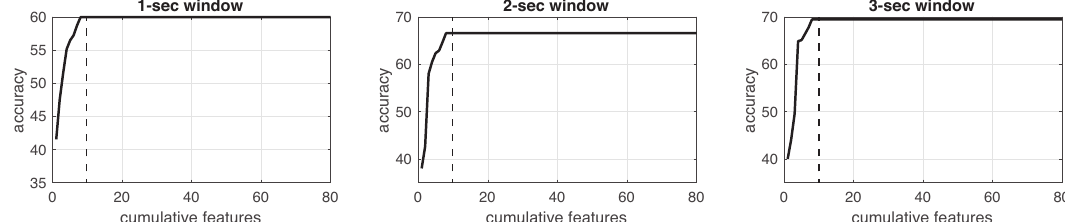
Figure 12. Accuracy performance on training using cumulative features for Experiment 5 : CAM. From left to right, it presents the performance using: 1-second length windowing, 2-second length windowing and 3-second length windowing. The dash line reports the number of cumulative features employed for the next steps.